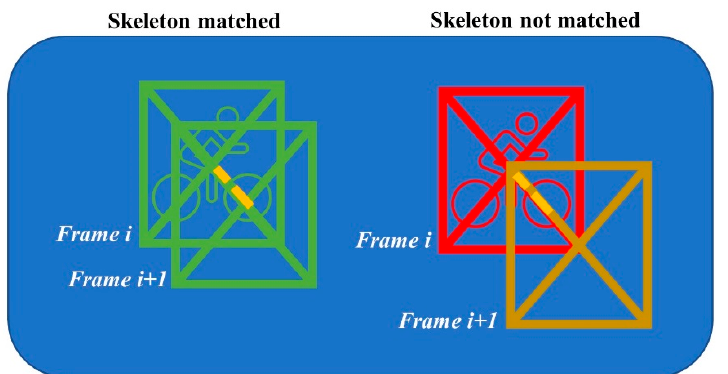
Figure 3. Illustration of the pose matching methodology. The yellow dotted line is the 25% threshold of the diagonal size. The poses on the left are matched between frame i and i + 1 as its distances between bounding boxes are less than 25% of the diagonal size, and the right poses are too far away to be matched.